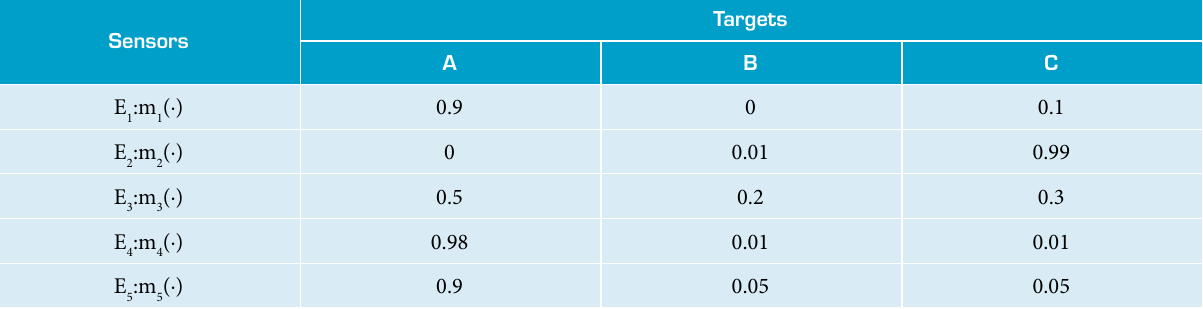
Table 3. Mass assignments of highly conflicting